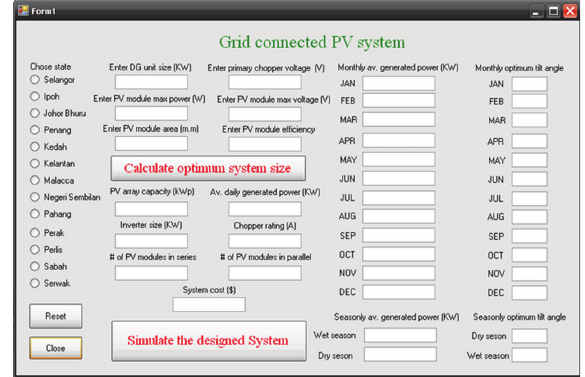
Figure 6: Interface for designing grid-connected PV